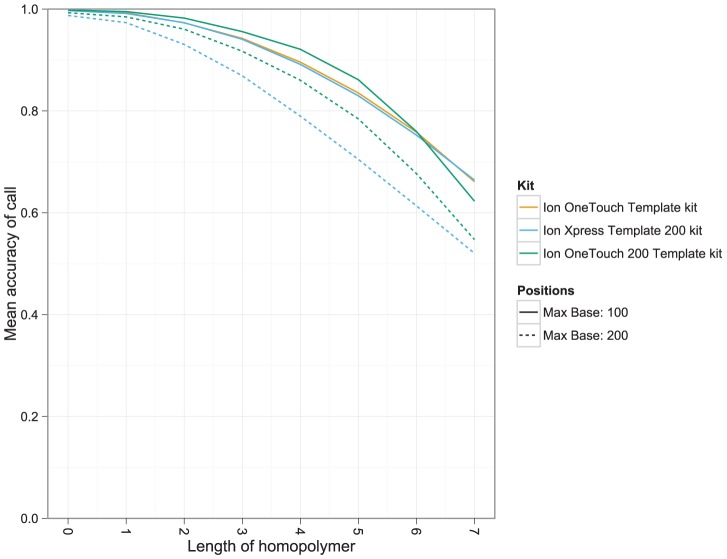
Calling accuracy decreases with homopolymer length.Lines show mean accuracy for each kit by reference homopolymer length, across bases 10–100 and bases 10–200, the latter range only relevant for the two 200 bp kits.